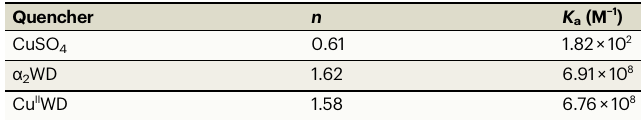
Table 3 | Calculated values of the association constant ( K a , M − 1 ) and the number of the bound molecules of the quencher to the HEWL